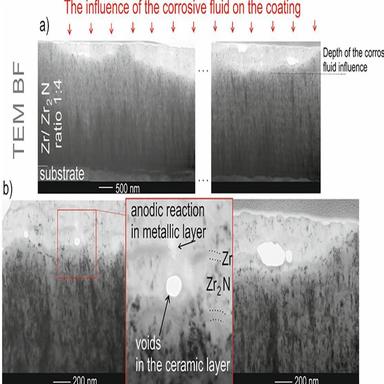
A cross-section image showing pitting corrosion in the Zr/Zr2N (1:4 ratio) multilayer coating performed by TEM; a) TEM BF image; and b) higher magnification of the image shown in a).